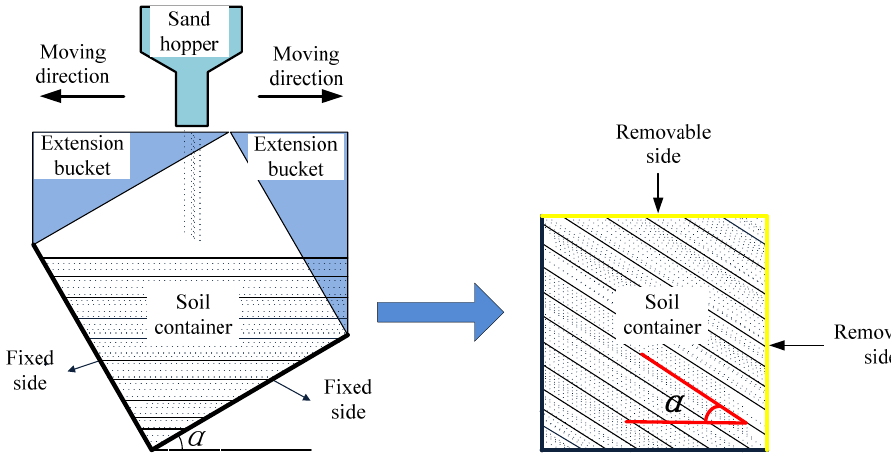
Figure 5. Process of preparing soil sample with deposition angle.